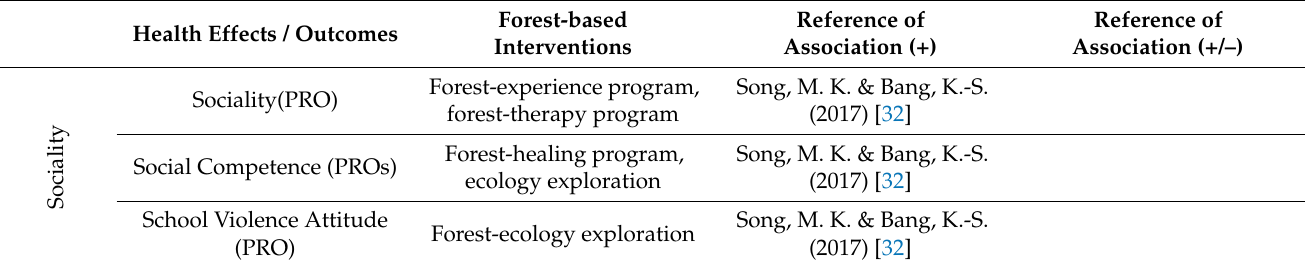
Table 8. Summary of associations between forest-based interventions and health effects / outcomes in sociality. Health Effects /